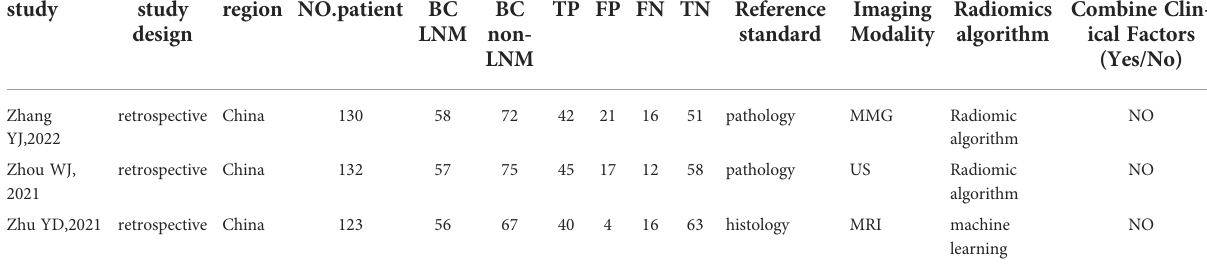
(Figure 5), suggesting the absence of publication bias among the studies.